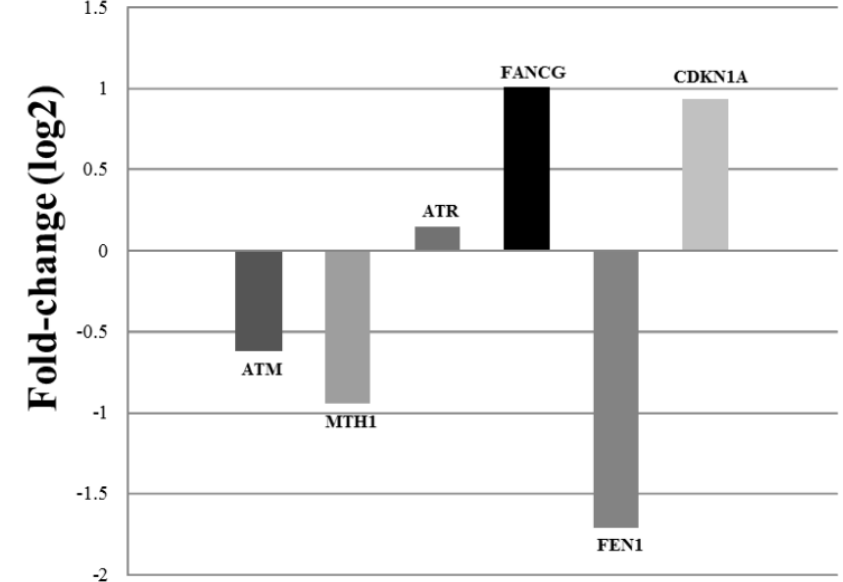
Figure 3. Relative gene expression (fold-change) for ATM , MTH1 , ATR , FANCG , FEN1 and CDKN1A genes in lymphocytes of AD patients compared with elderly matched control subjects analyzed by qRT-PCR. HPRT1 , GUSB and B2M were used as endogenous